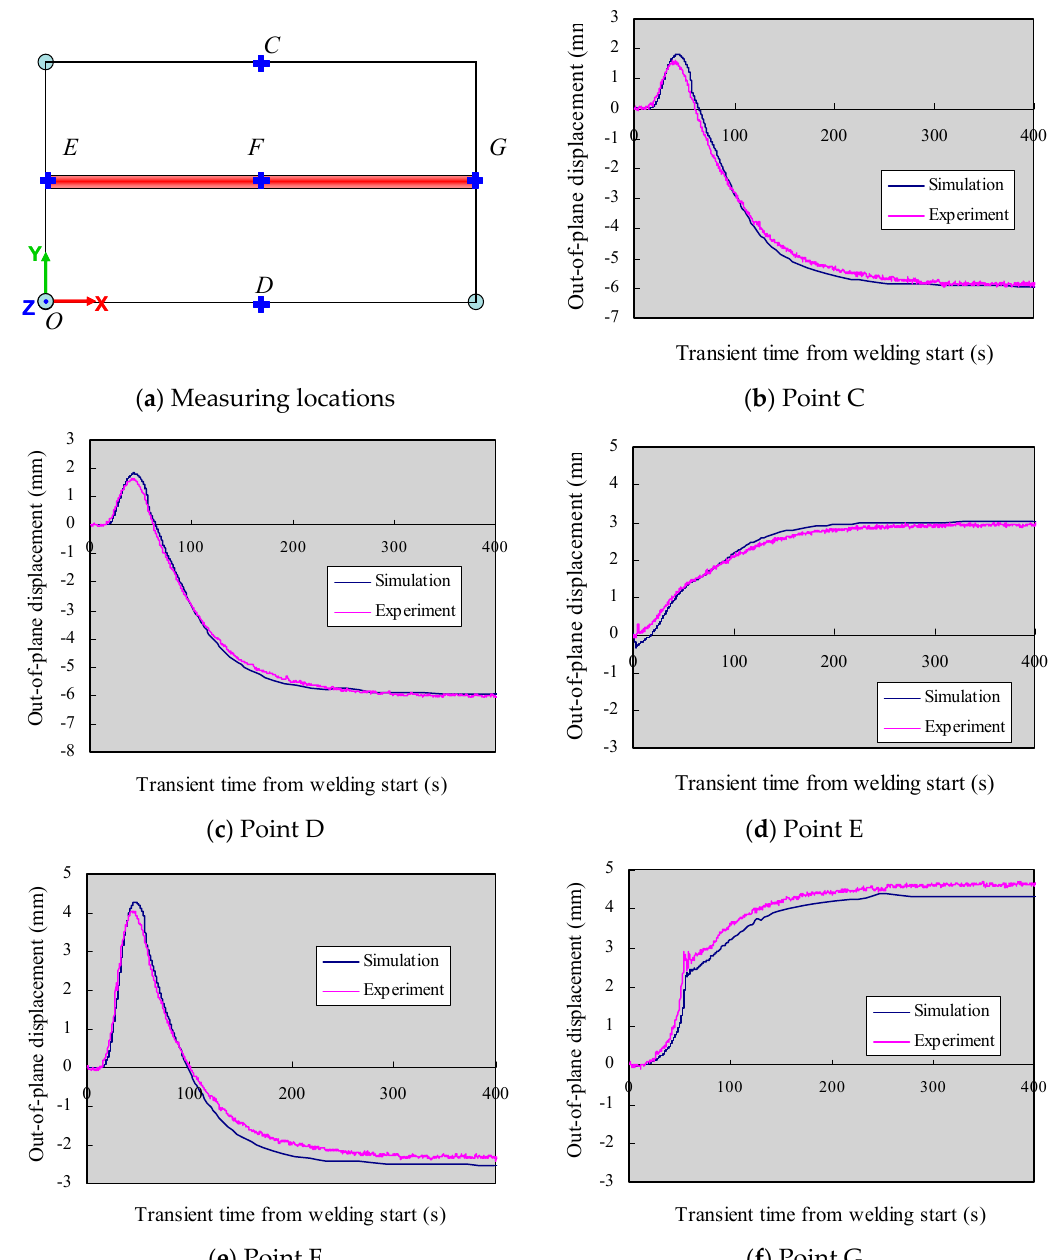
Figure 10. Out ‐ of ‐ plane displacement at various locations during welding process. ( a ) Measuring locations; ( b ) Point C; ( c ) Point D; ( d ) Point E; ( e ) Point F; ( f ) Point G.